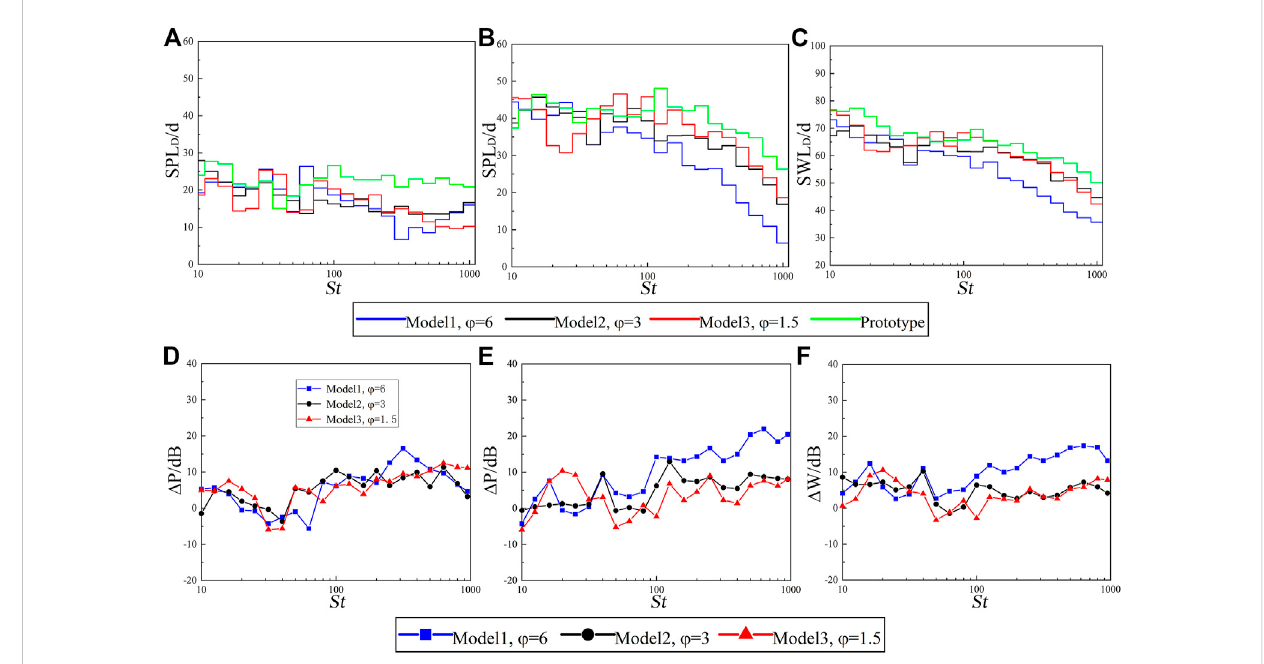
Extrapolated results and error value between scale models and hypothetical prototype. (A,D) SPL of the 0 ° mearing point. (B,E) SPL of the 90 ° mearing point. (C,F) SWL of the ISO3744 mearing point.